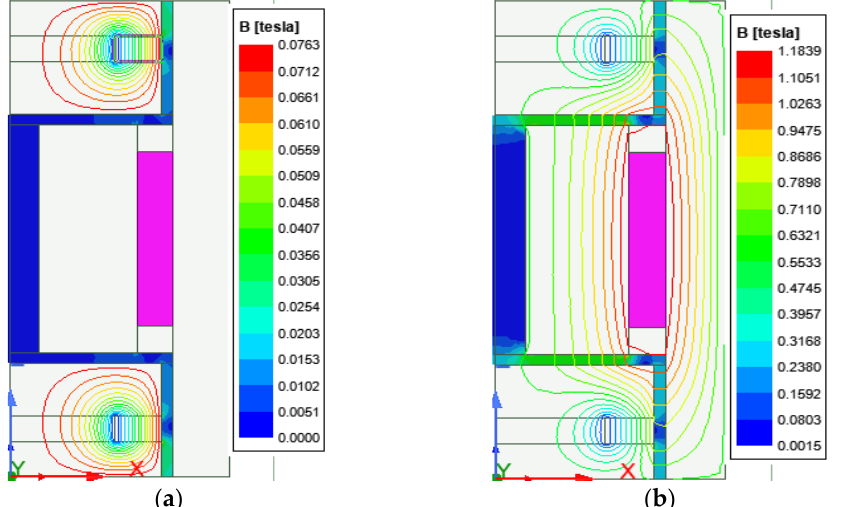
Figure 3. Distribution of magnetic field lines and flux density when: ( a ) only the PM is operating; ( b ) both the PM and coil are operating.